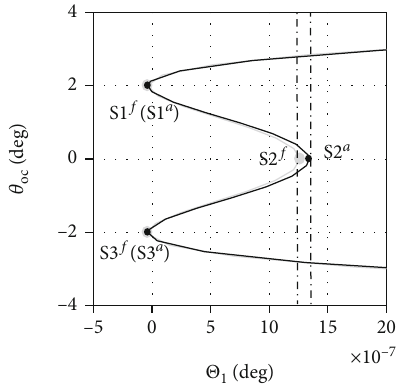
Figure 15: Independent computational results of the fore and aft